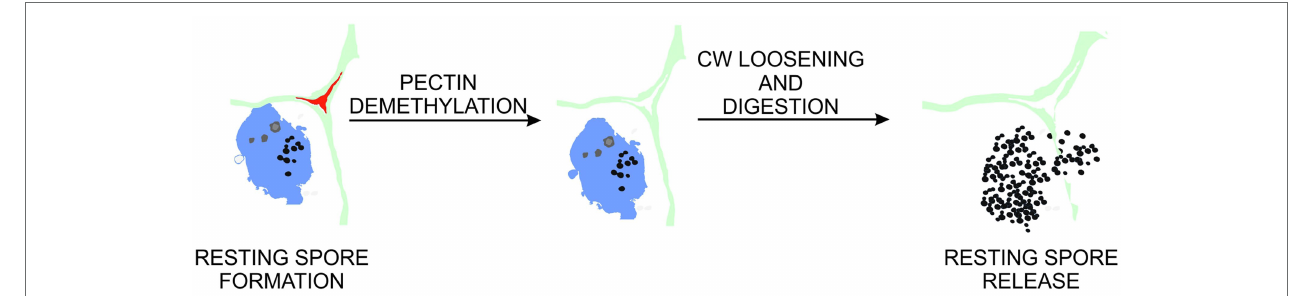
FIGURE 6 | Proposed role of pectin demethylation in gall maturation and resting spore release. At late stages of clubroot disease, cell walls within galls undergo pectin demethylation. This leads to increased exposure of cell wall components to enzymes involved in pectin, cellulose and hemicellulose degradation. These